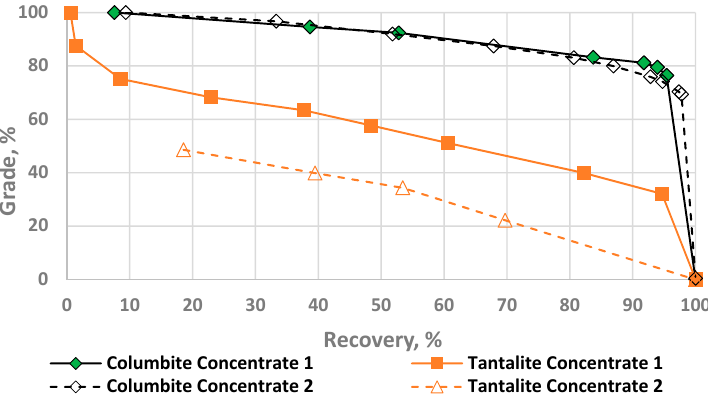
Figure 21. Columbite and tantalite theoretical grade recovery curves for the first two concentrate products of Wilfley separation. Minerals 2017 , 7 , 194